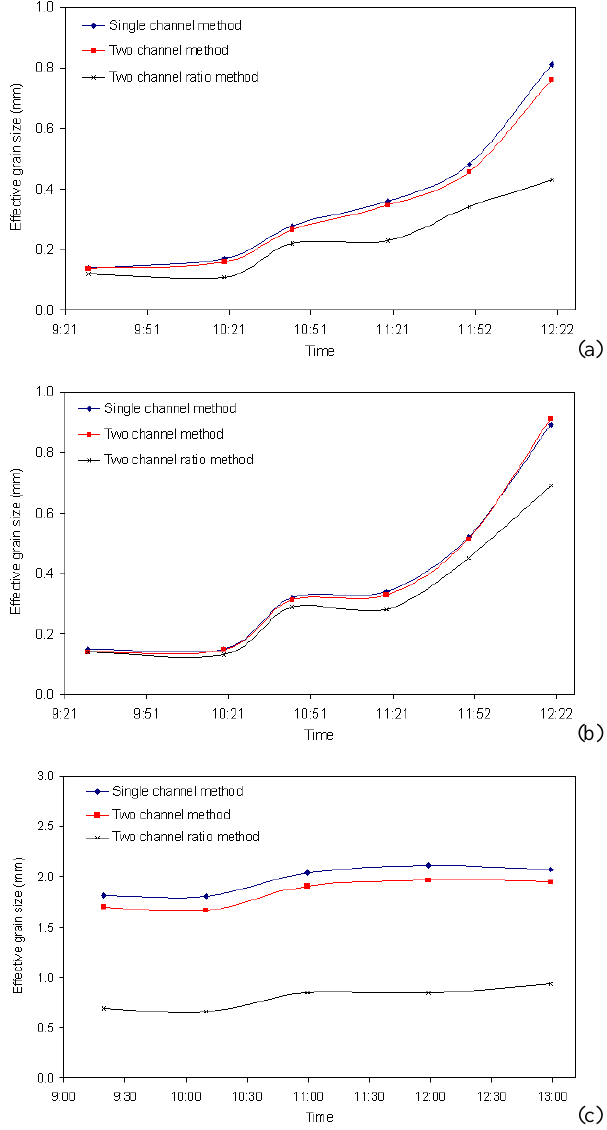
Fig. 10. Comparison of retrieved snow grain sizes; (a) snow Type- I using 1050nm channel; (b) snow Type-I using 1240nm channel and (c) snow Type-II using 1050nm